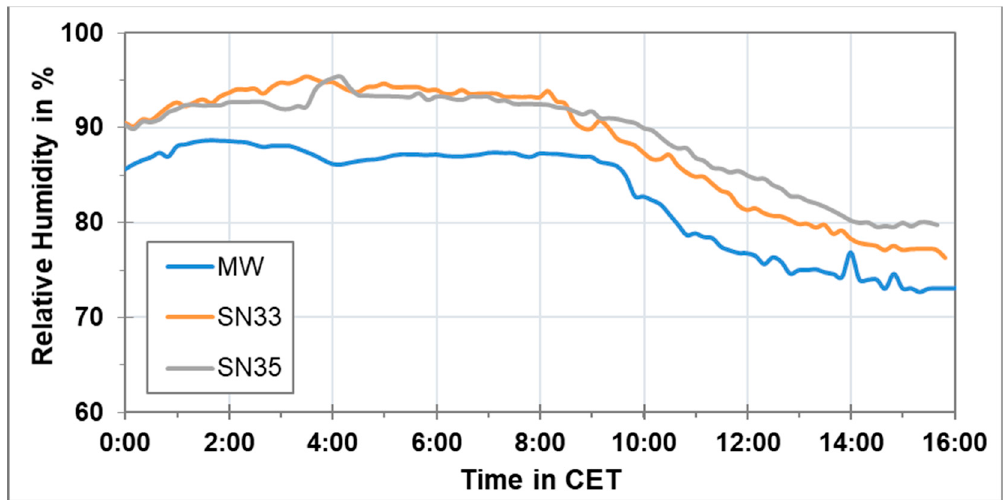
Figure 16. Relative humidity at three stationary locations along the route of the rack railway on 22 February 2019 from 00:00 CET until 16:00 CET.